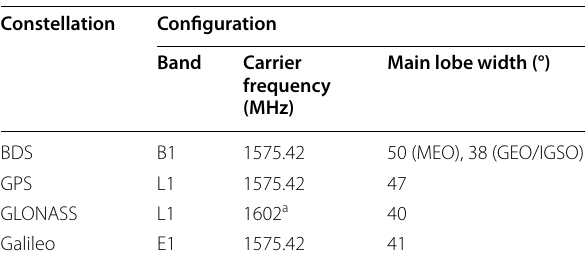
a GLONASS frequency depends on channel number k, in this simulation the value is simplified to 1602